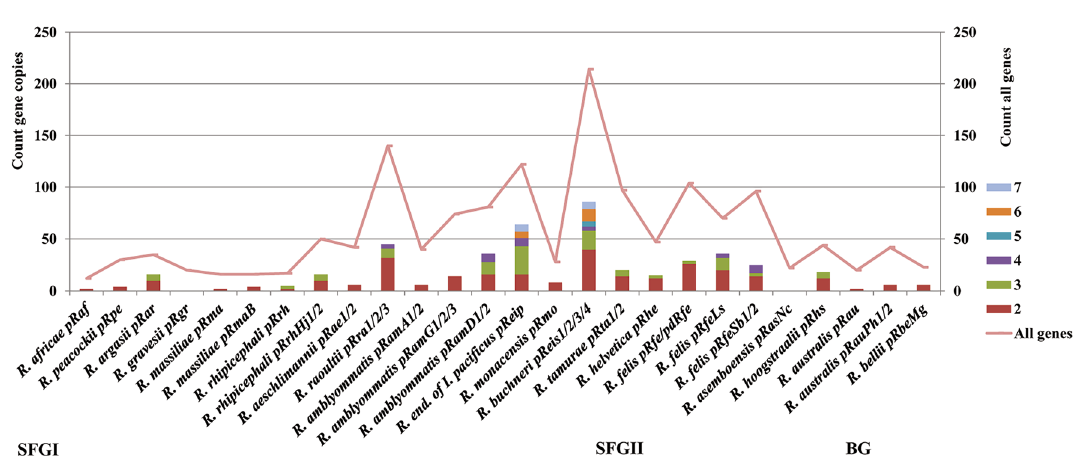
Figure 5. Distributions of gene proliferations identified in the pan-plasmidome across 19 Rickettsia spp. (26 strains, 41 plasmids). The x-axis represents the 26 Rickettsia strains, each harbouring from 1 to 4 plasmids. The left y-axis shows the total number of plasmidic gene copies present in each strain. For each plasmid, colours indicate the numbers of genes according to their copy counts (from 2 to 7). The right y-axis displays the total plasmidic gene count per